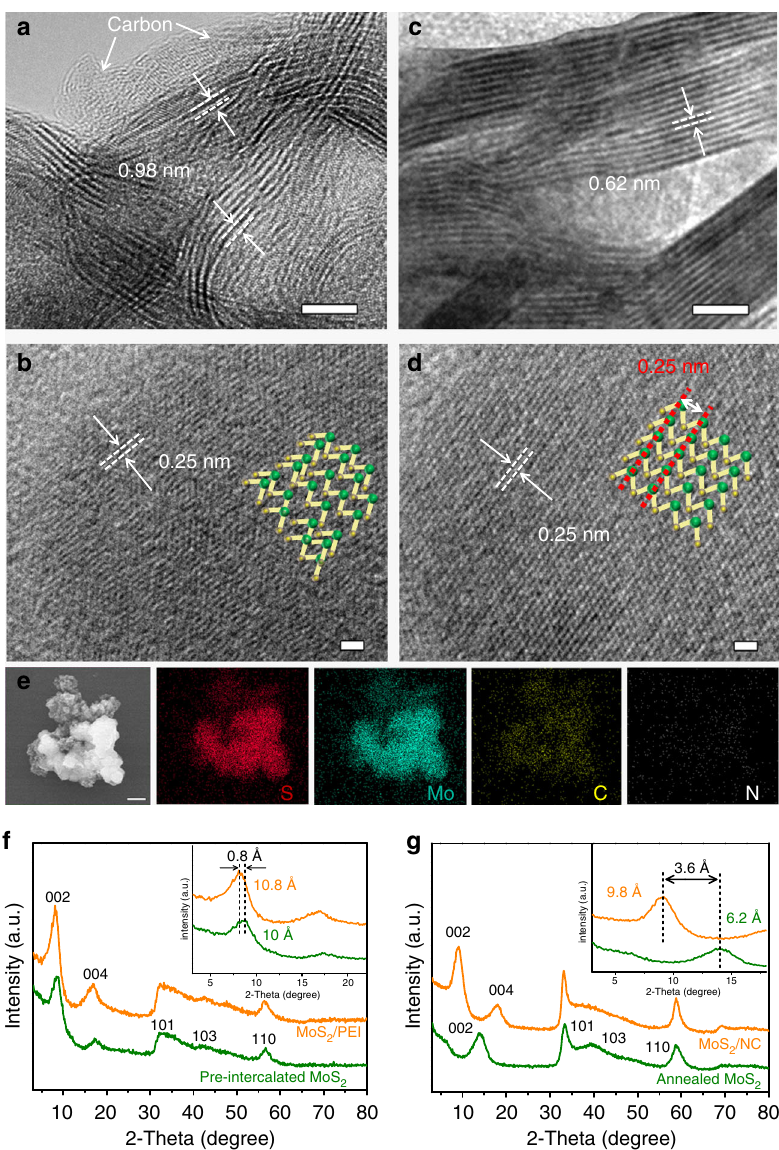
Fig. 2 Characterization of the MoS 2 /NC heteroaerogel and MoS 2 nanosheets. a – d TEM images of the MoS 2 /NC heteroaerogel derived from the intercalation of PEI (Mw = 600) ( a , b ) and the annealed MoS 2 nanosheets ( c , d ). Insets of ( b , d ) show the corresponding SAED patterns. e SEM-EDS mapping images of the MoS 2 /NC heteroaerogel. f XRD patterns of the MoS 2 nanosheets and MoS 2 -PEI composite obtained after freeze-drying. g XRD patterns of MoS 2 /NC heteroaerogel obtained after thermal treatments. Scale bars: a , c 5 nm; b , d 1 nm; e 1 µ